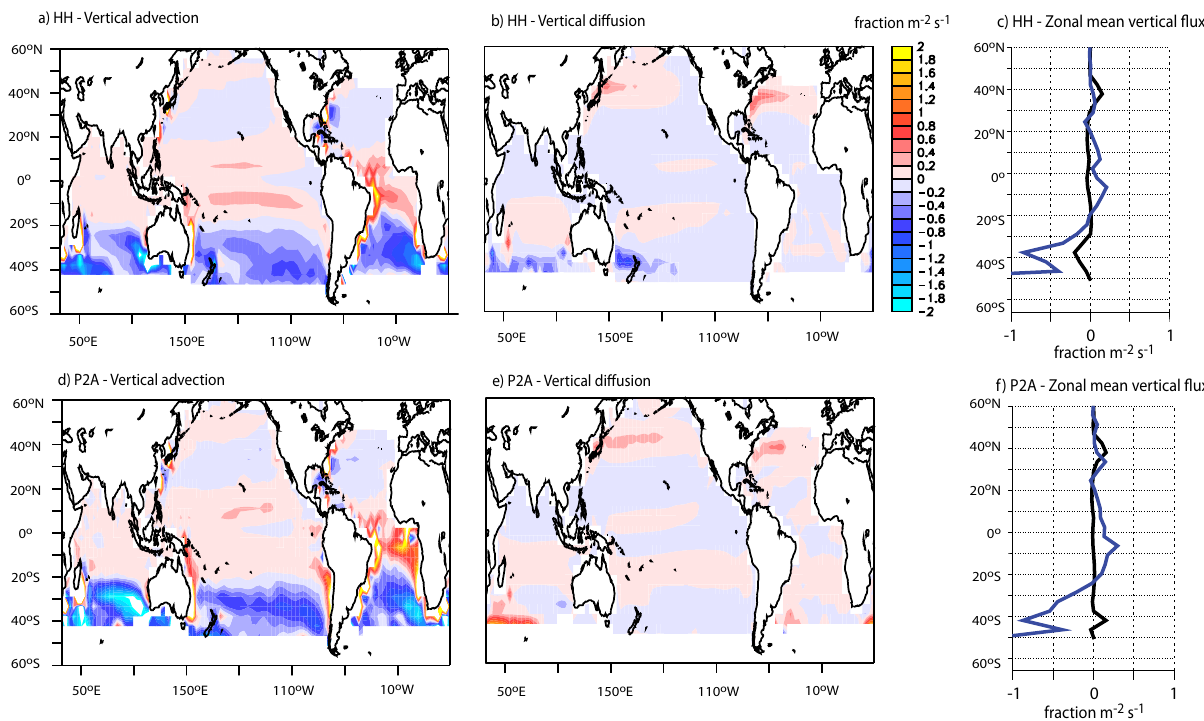
Fig. 12. Vertical fluxes of SAMW dye (in fractional concentration per m 2 s) at the depth of the 26.5 isopycnal. Upper row is for the HH model and lower row for P2A. The left hand panels are the vertical advective flux ( wC , where w is the vertical velocity and C is the concentration of the SAMW dye tag). The right hand panels are the vertical diffusive flux ( κ v d C /d z , where κ v is the coefficient of diapycnal diffusion). The diffusive flux includes mixing due to convection and stirring due to the GM transport. The colorbar to the right of panel (b) applies to all maps, and positive numbers represent an upwards flux. The line plots are the zonal means of the maps (black for vertical advection and blue for vertical